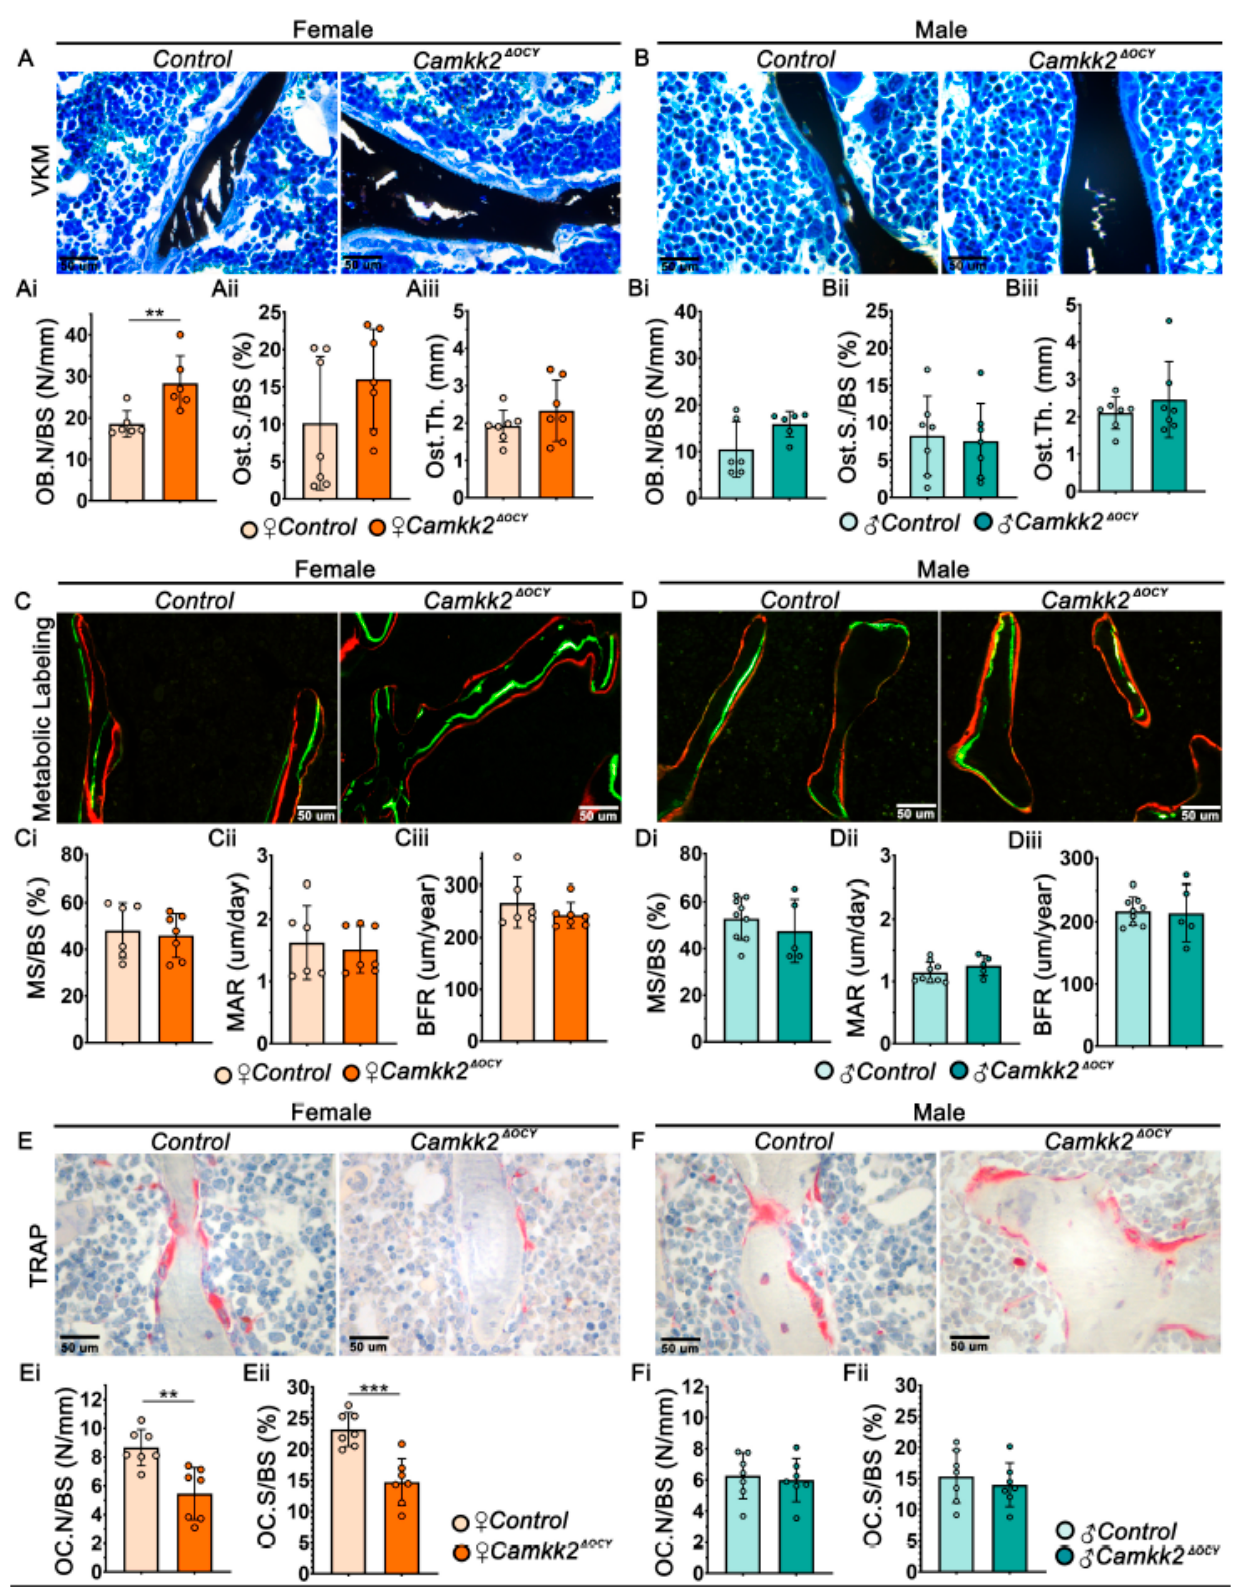
Figure 2. Altering osteocyte expression of CaMKK2 suppresses OCs without influencing OBs. ( A , B ) Representative images of female and male distal femur trabeculae stained with Von Kossa and McNeil’s tetrachrome (VKM; magnification 400 × ); mineralized bone = black; osteoid = light blue. ( Ai , Bi ) Mean osteoblast numbers (N.Ob/BS), ( Aii , Bii ) osteoid surface (OS/BS), and ( Aiii , Biii )